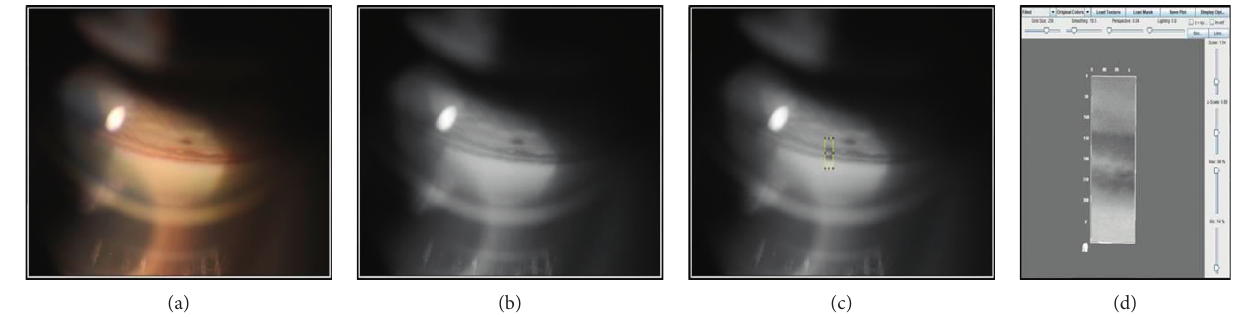
Figure 1: Green channel of a gonioscopy image used for ROI selection and consequent CLAHE filtering. (a) Gonioscopy image. (b) 8-bit converted image. (c) Selection of area of interest. (d) Interactive 3D-surface plot.